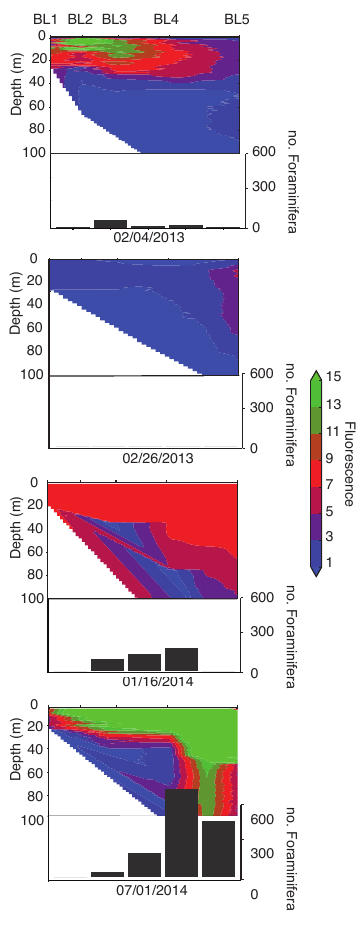
Figure 7. Water column fluorescence data and total number of foraminifera recovered at stations BL 1–5 on 4 days of extremely low productivity. CTD data from these five stations demonstrate small-scale variability from 1 to 32km offshore along the continen- tal shelf. This is compared with the total number of foraminifera retrieved at each of these stations.